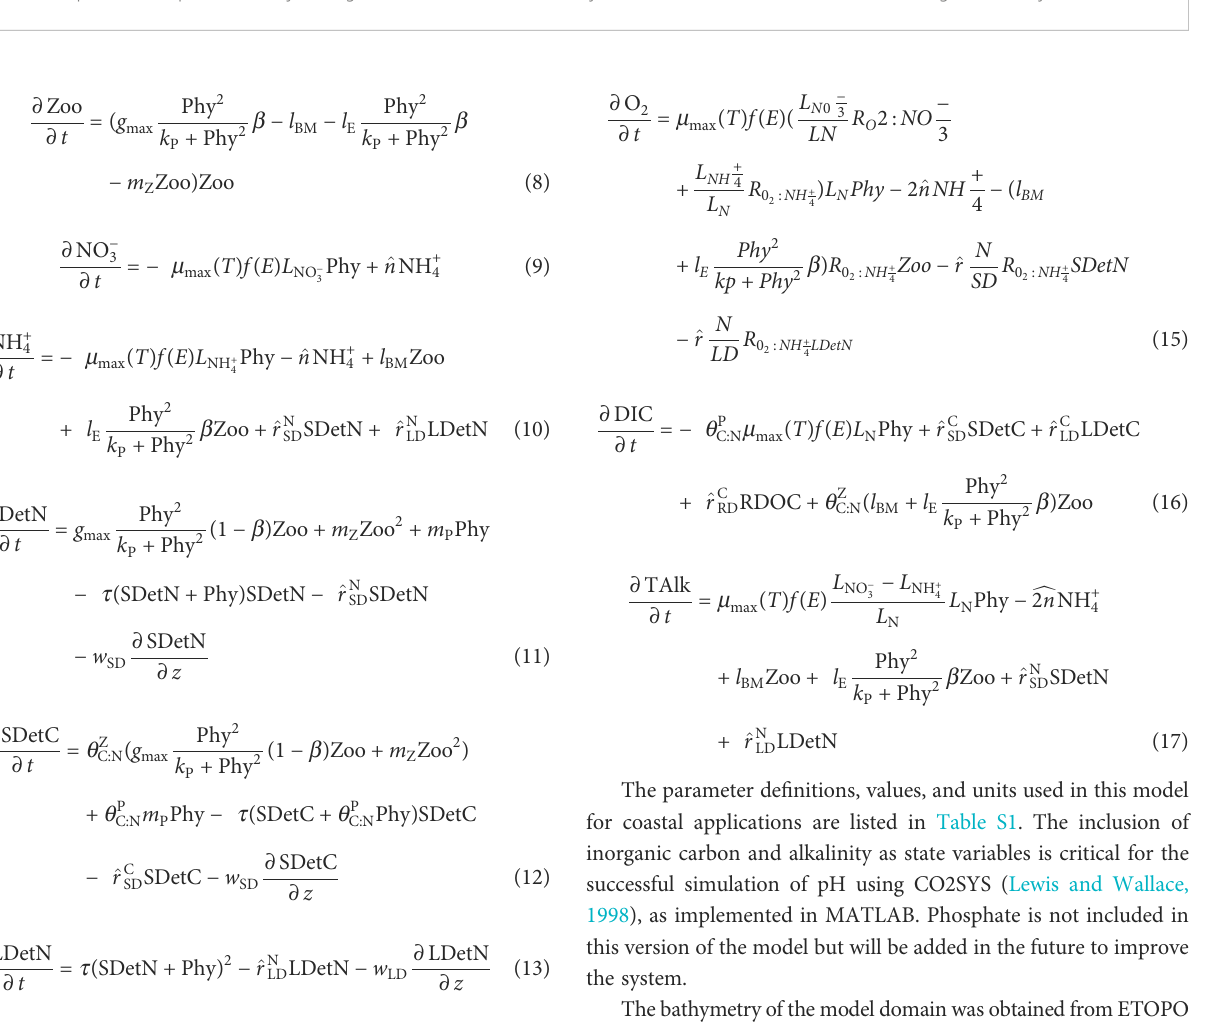
FIGURE 2 General setup of the Coupled Great Bay Ecological Environment Prediction System (CGEEPS) (A) ; the structure of the biogeochemistry model (B)